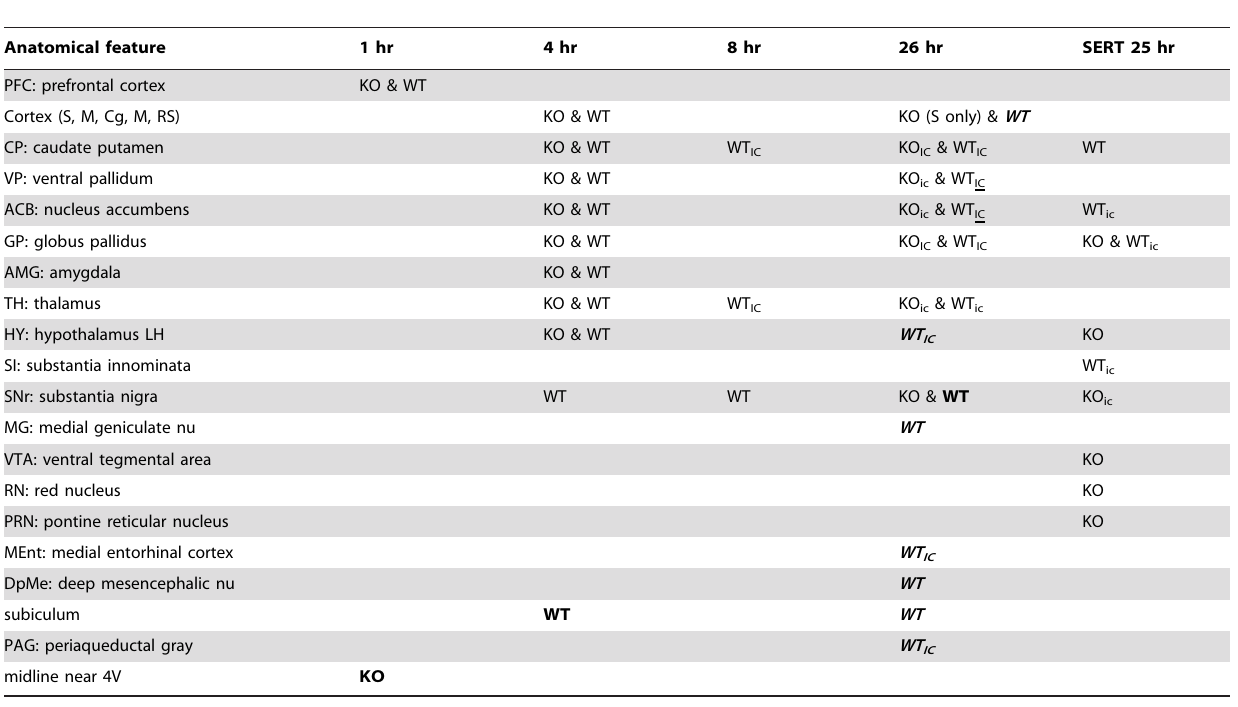
Table 2. Anatomical features highlighted by MEMRI as a function of time after PFC stereotaxic injection.